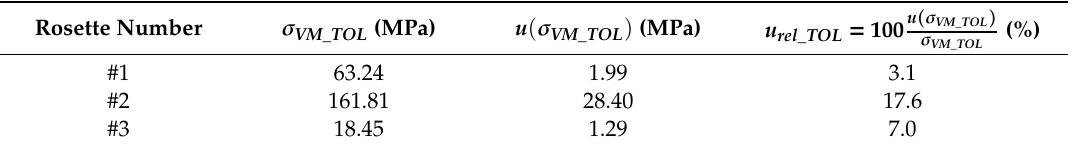
Table 11. Uncertainty quantification of the crank arm model due to the geometric tolerance of the blind